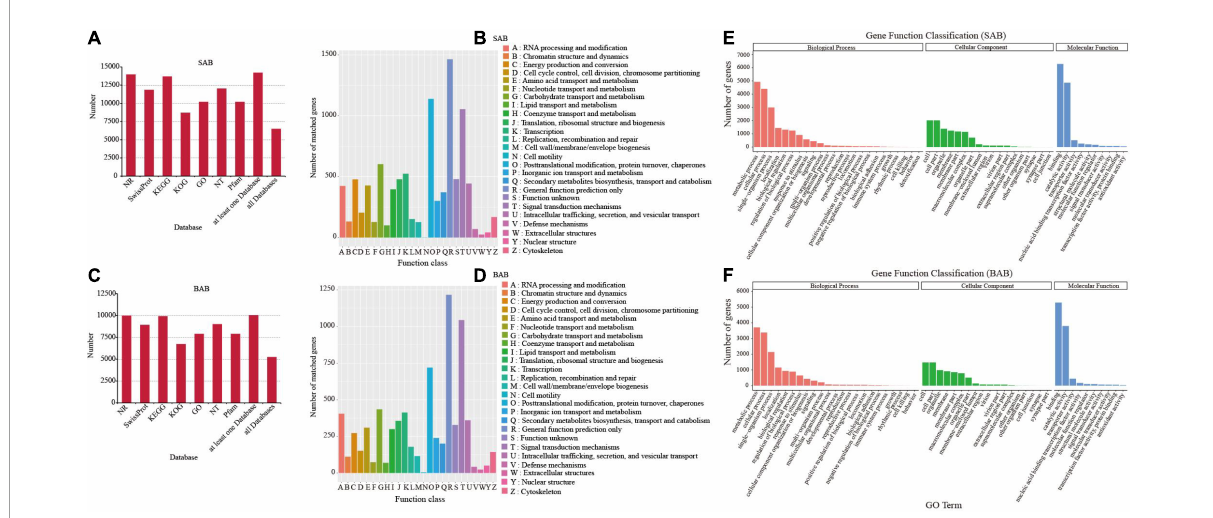
FIGURE3 Gene annotation and functional classification. (A) Statistical chart of H. ammodendron transcripts annotated in 7 databases; (B) annotation results of H. ammodendron KOG distribution; (C) statistical chart of the results of annotation of the transcripts of H. persicum in 7 databases; (D) KOG distribution annotation results of H. persicum ; (E) H. ammodendron GO annotation function diagram; (F) H. persicum GO annotation function diagram. SAB and BAB are the names of mixed samples of H. ammodendron and H. persicum under two soil moisture conditions.